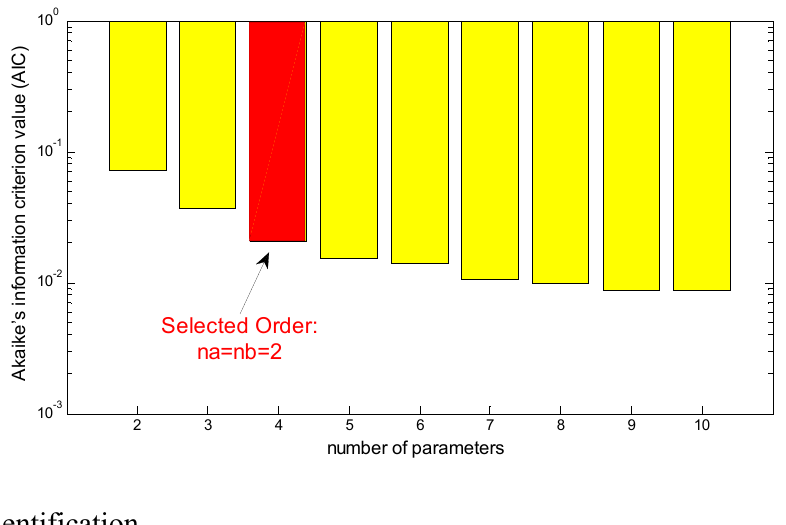
Figure 10. Akaike’s information criterion (AIC) with corresponding number of parameters in ARX model.